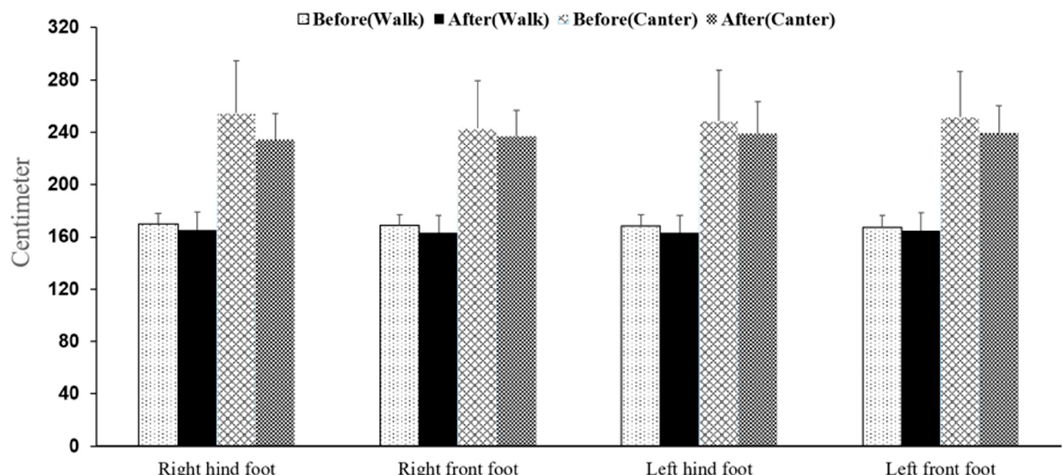
Figure 4. Stride lengths.